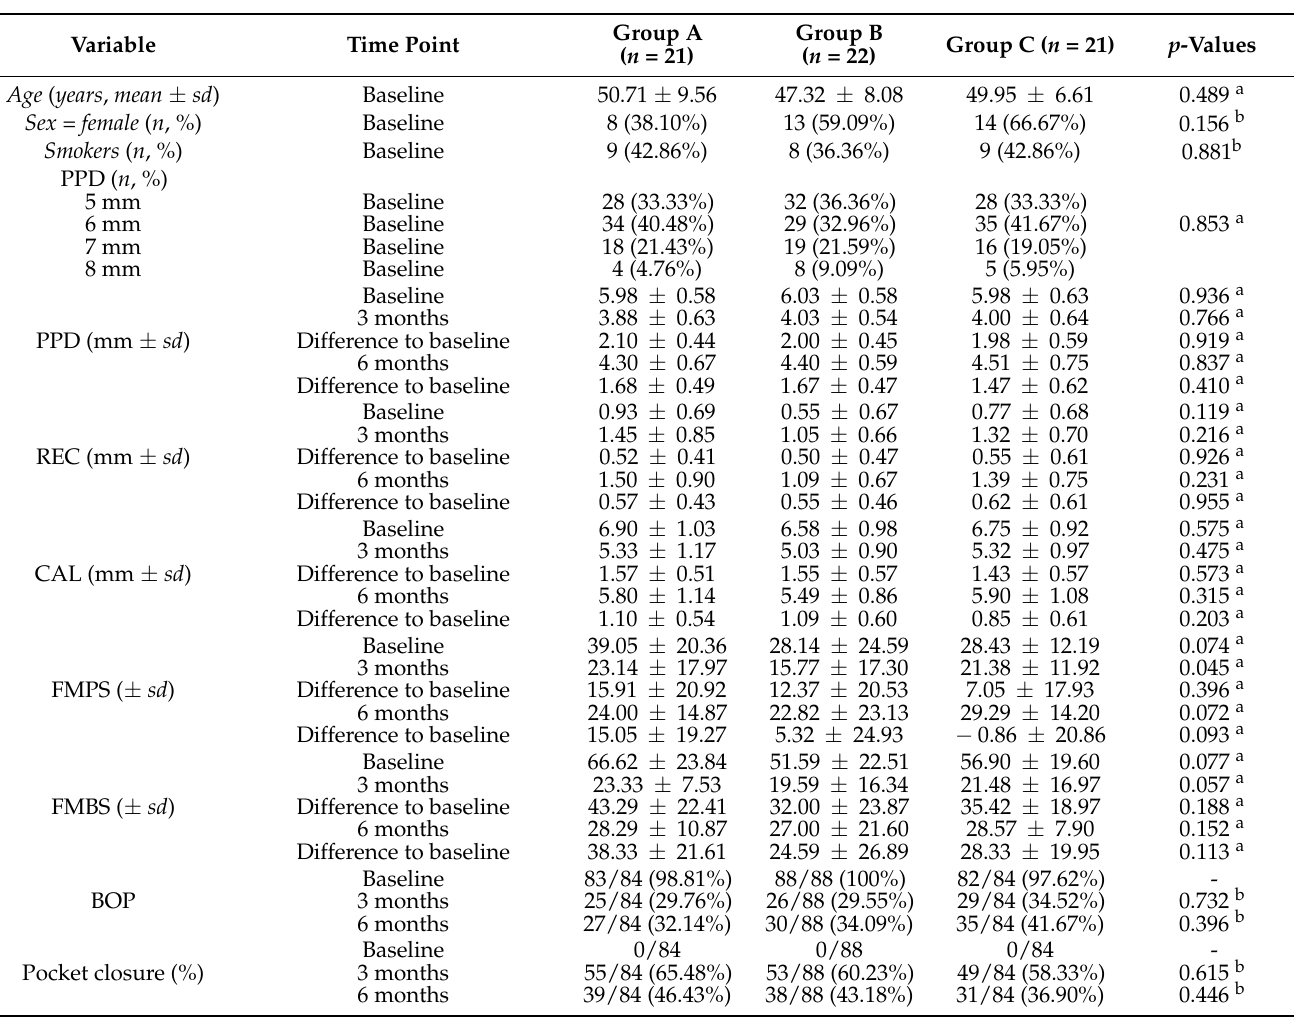
Table 1. Demographic data and full-mouth clinical parameters at baseline and follow-up visits in the three groups.